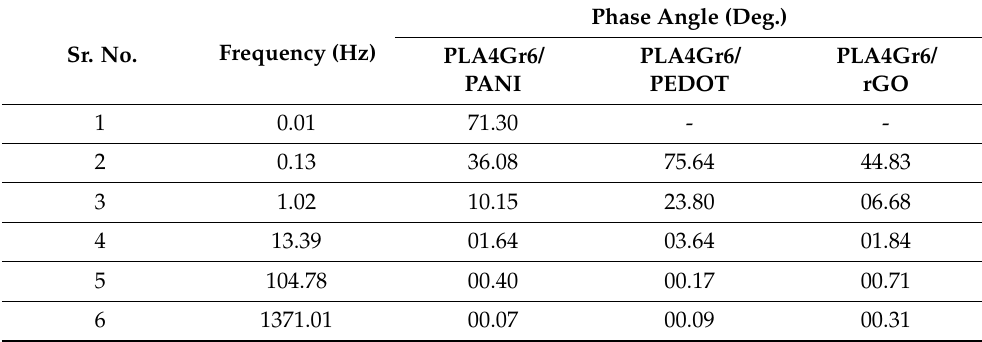
Table 2. Phase angle between current and voltage on few selected frequencies for the four samples recorded in